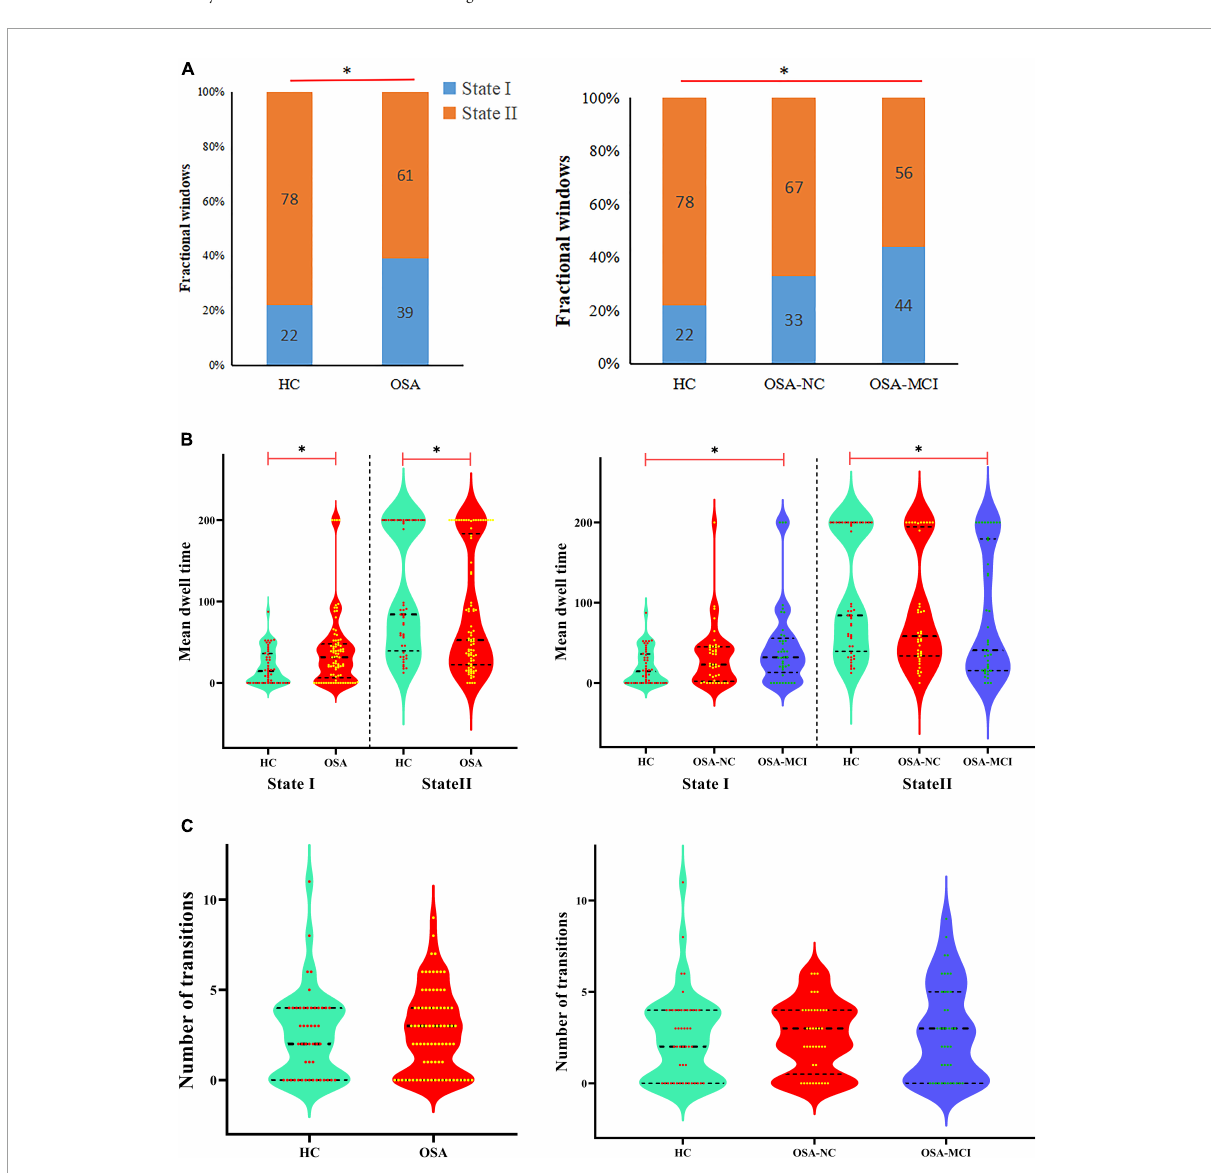
FIGURE5 Temporal properties of dynamic functional network connectivity states for the OSA and HC groups. (A) Percentage of total time subjects spent in each state. (B) Mean dwell time and (C) number of transitions between states were plotted using violin plots. Horizontal black dotted lines indicate group medians and inter-quartile range. ∗ p < 0.05. OSA, obstructive sleep apnea; HC, healthy control; MCI, mild cognitive impairment; NC, normal